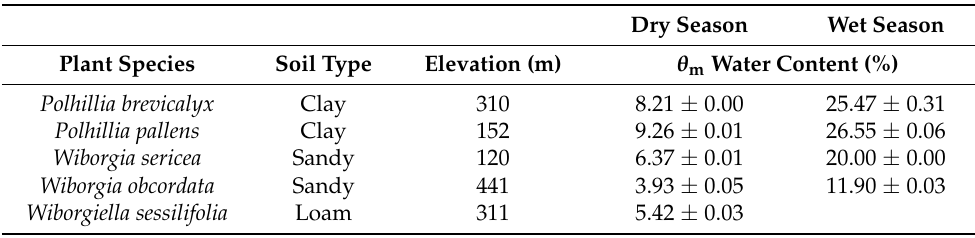
Table 2. Information on rhizosphere soil type, elevation and dry weight of soils obtained during the wet and dry seasons from Polhillia , Wiborgia and Wiborgiella species in the Cape fynbos biome of South Africa.